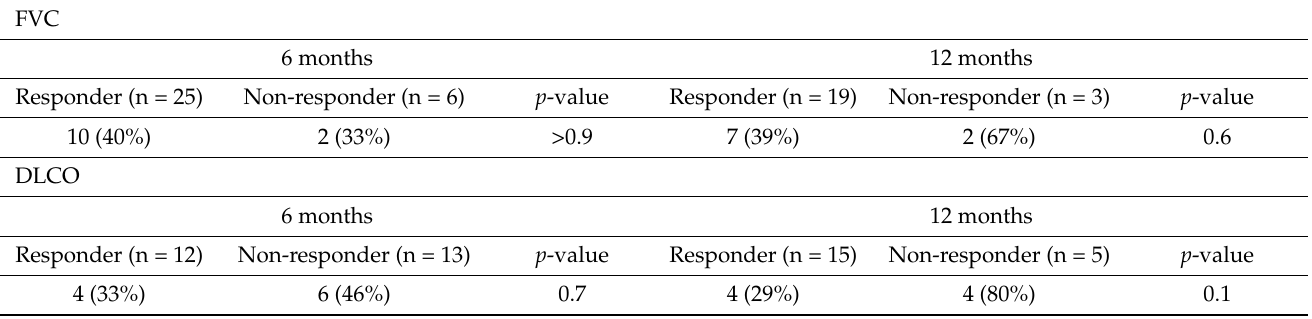
Table 2. Steroid use in responders and non-responders for FVC and DLCO.